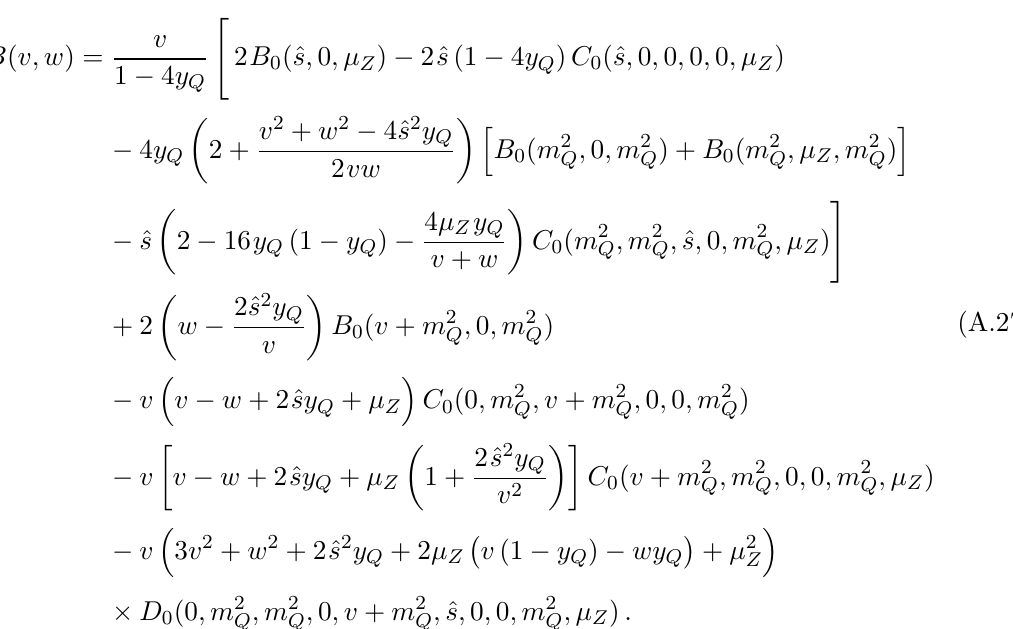
Figure 15 . Examples of graphs that a(cid:11)ect the production asymmetry of heavy quarks at O ( (cid:11)(cid:11) 2 and involve the exchange of a Z boson. Consult the main text for additional